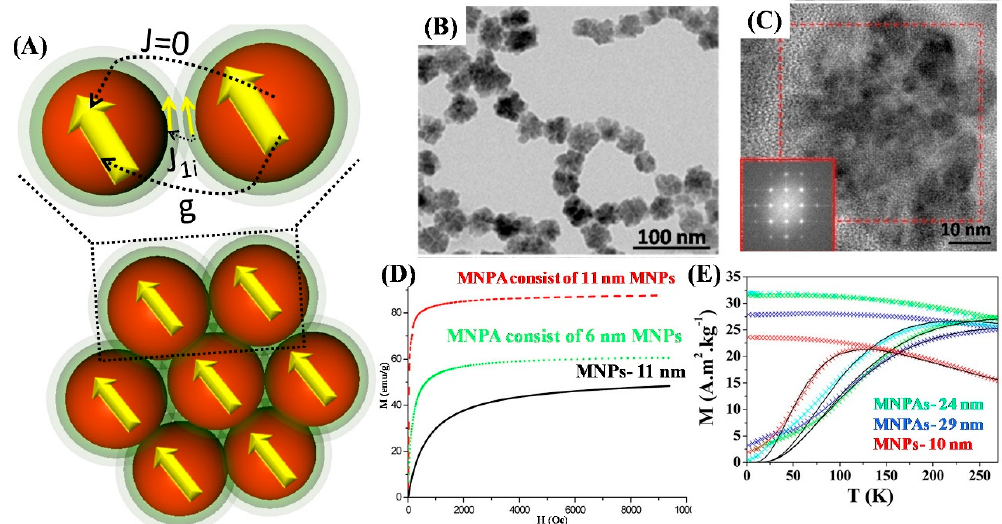
Figure 15. ( A ) Schematic illustration of the supermoment structure and the intra-particle as well as inter-particle interactions in a nanoparticle assembly. Outermost light green color: Surfactant polymeric layer [70]. ( B ) TEM and ( C ) HR-TEM micrographs and Fourier transformation of flowerlike nanoparticles [24]. ( D ) Magnetization curves of 11 nm-sized nanoparticles synthesized via coprecipitation (green dotted line), 6 nm nanoparticles synthesized in diethylene glycol (black solid line) and 11 nm nanoparticle assemblies synthesized in a mixture of diethylene glycol and N -methyl diethanolamine (red dashed line). ( E ) ZFC-FC magnetization curves taken with an applied field of 50 Oe: 24 nm (cyan), 29 nm (blue)-sized nanoparticles assembly and 10 nm (red)-sized nanoparticles [25].